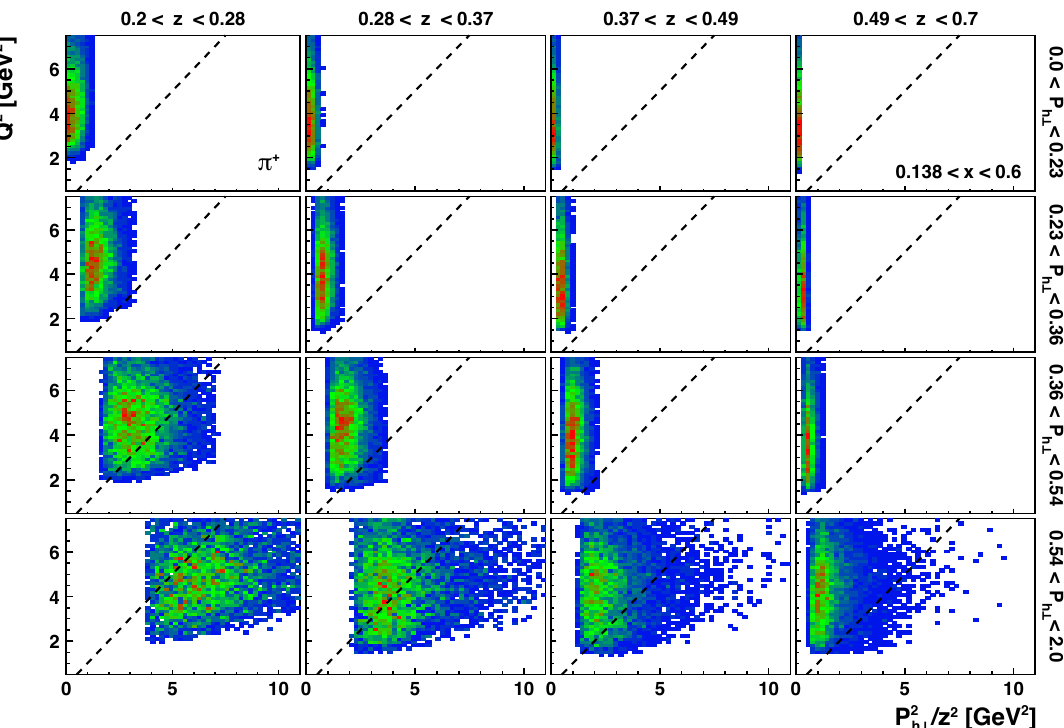
Figure 46 . The distribution of π + events in the Q 2 – P 2 the highest x bin. The Q 2 = P 2